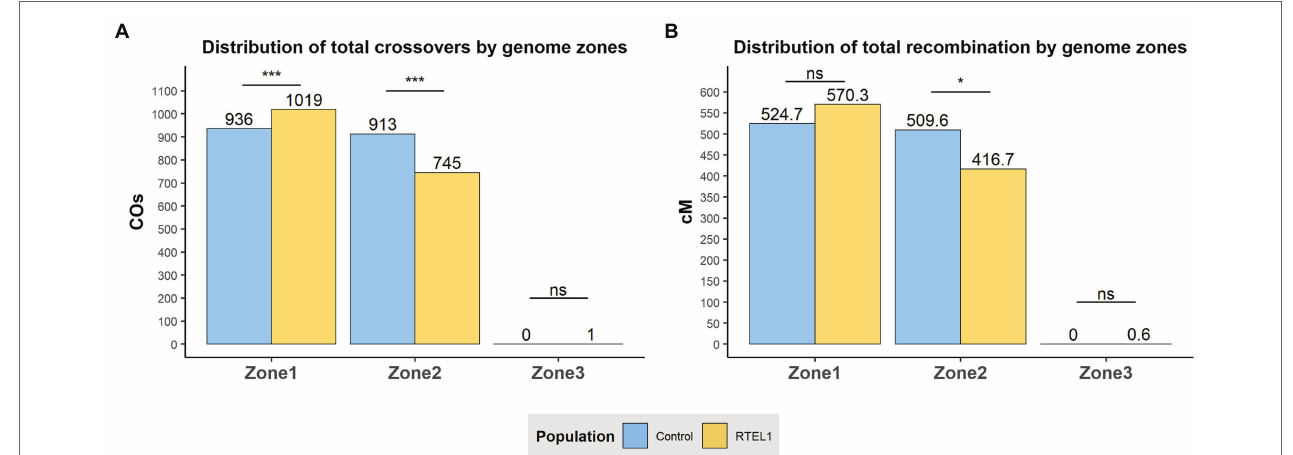
FIGURE 2 | Effect of RTEL1 downregulation on meiotic recombination and crossover events at sub-chromosomal level. Genome-wide distribution of crossover events (A) and recombination (B) by genomic zone for the control GP × BW (blue) and RTEL1 RNAi × BW (yellow) populations. The genomic physical limits between the genomic zones are described in Mascher et al. (2017). Significance in (A) refers to the comparison with the χ -squared test of the proportion of crossovers and in (B) to the Wilcoxon’s signed rank in each zone between population tests. ns = not significant; * p < 0.05; and *** p < 0.001.